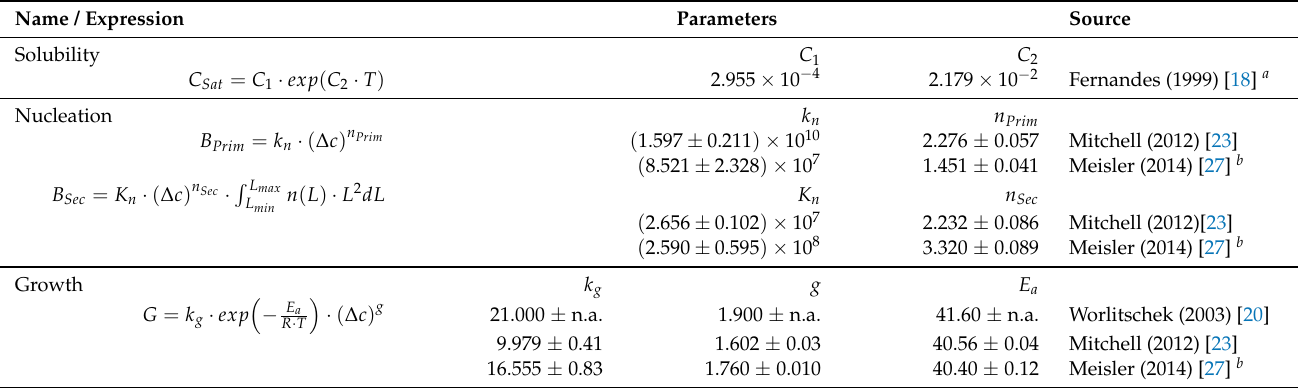
Table 1. Literature data on the solubility and kinetics of paracetamol crystallization from the ethanol and parameter values with 95% confidence